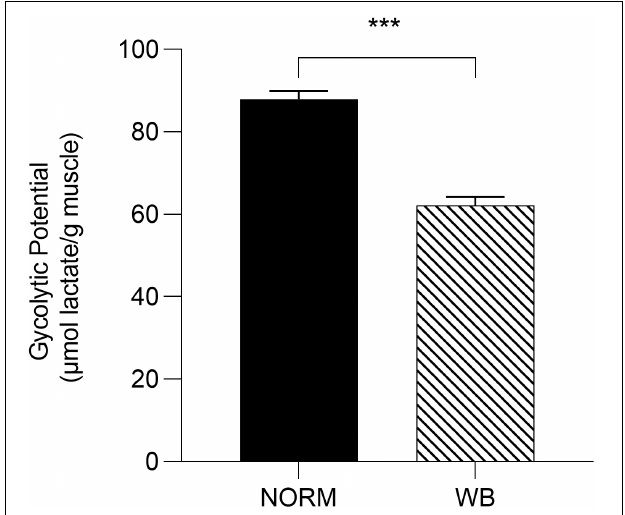
FIGURE 4 | Glycolytic potential ( µ mol lactate/g meat) of unaffected (NORM) and wooden breast (WB) broiler pectoralis major muscles ( n = 12/group). Data represent means ± SEM. Asterisks indicate a significant difference between experimental groups (*** P < 0.001).